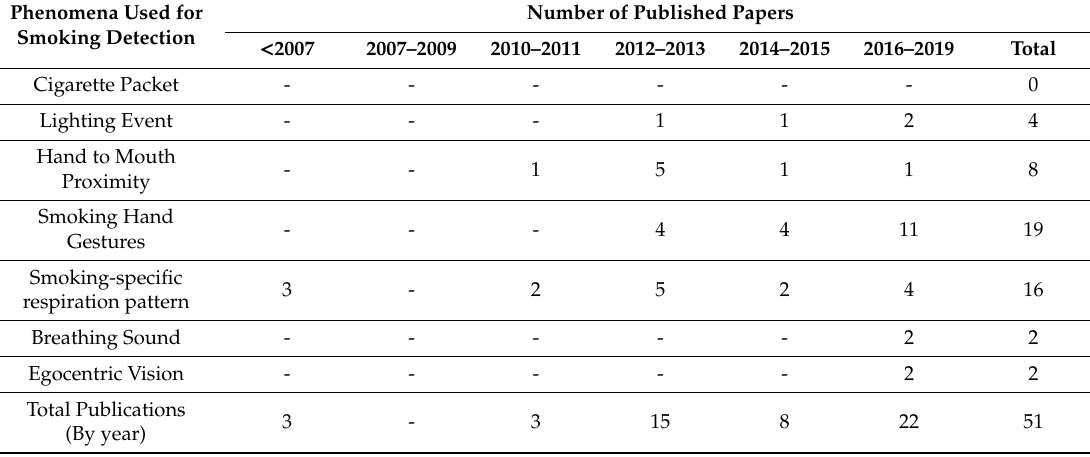
Table 3. Articles on smoking detection employing wearable sensors targeting the behavioral- physiological manifestations of smoking.